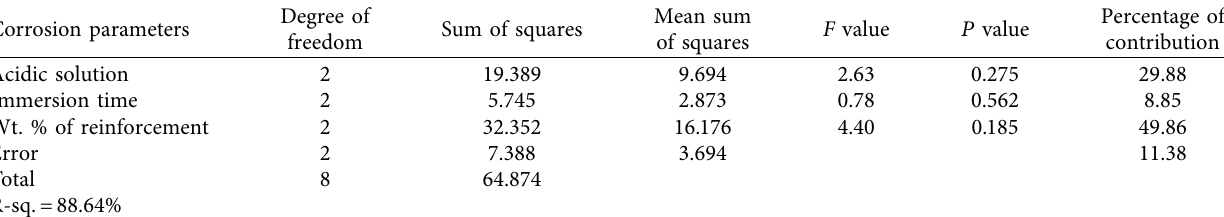
Table 5: ANOVA for corrosion